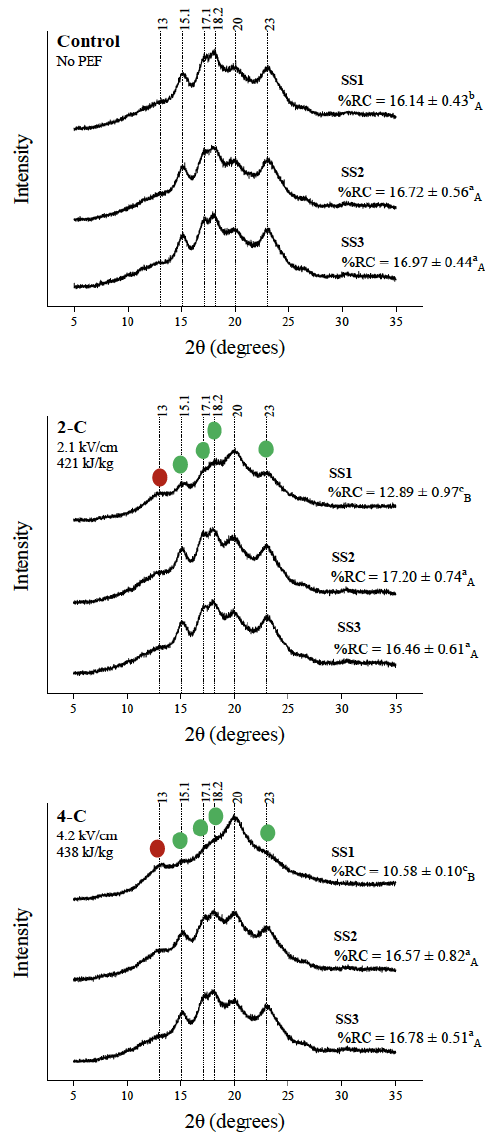
Figure 6. X-ray diffractograms and percent relative crystallinity (%RC) of flour segments collected from PEF-treated oat flour at 418 – 484 kJ/kg. The %RC values are displayed as mean ± standard error of mean ( n = 3, collected and pooled from 24 – 34 independent samples). Means sharing the same lowercase letters in superscript indicate no significant difference ( p < 0.05) between treatments obtained from the same segment (e.g., 2-C, SS1 vs. SS2 vs. SS3). Means sharing the same uppercase letters in subscript indicate no significant difference ( p < 0.05) between flour segments obtained from different treatments (e.g., SS1, Control vs. 2-C vs. 4-C). Green dots direct to the modification of spe- cific peaks due to PEF treatment. Red dots highlight the new peaks observed in flour segments col- lected from PEF-treated oat flour.